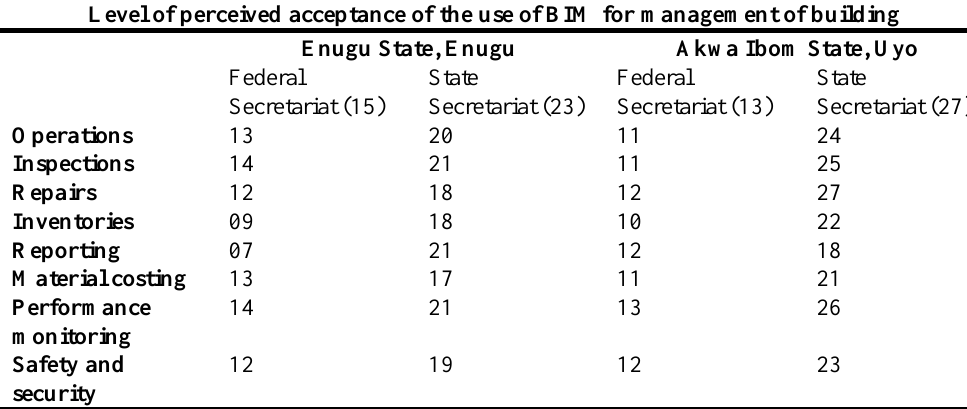
Table 6. The Level of Acceptance of the Use of BIM Property Management (developed by the